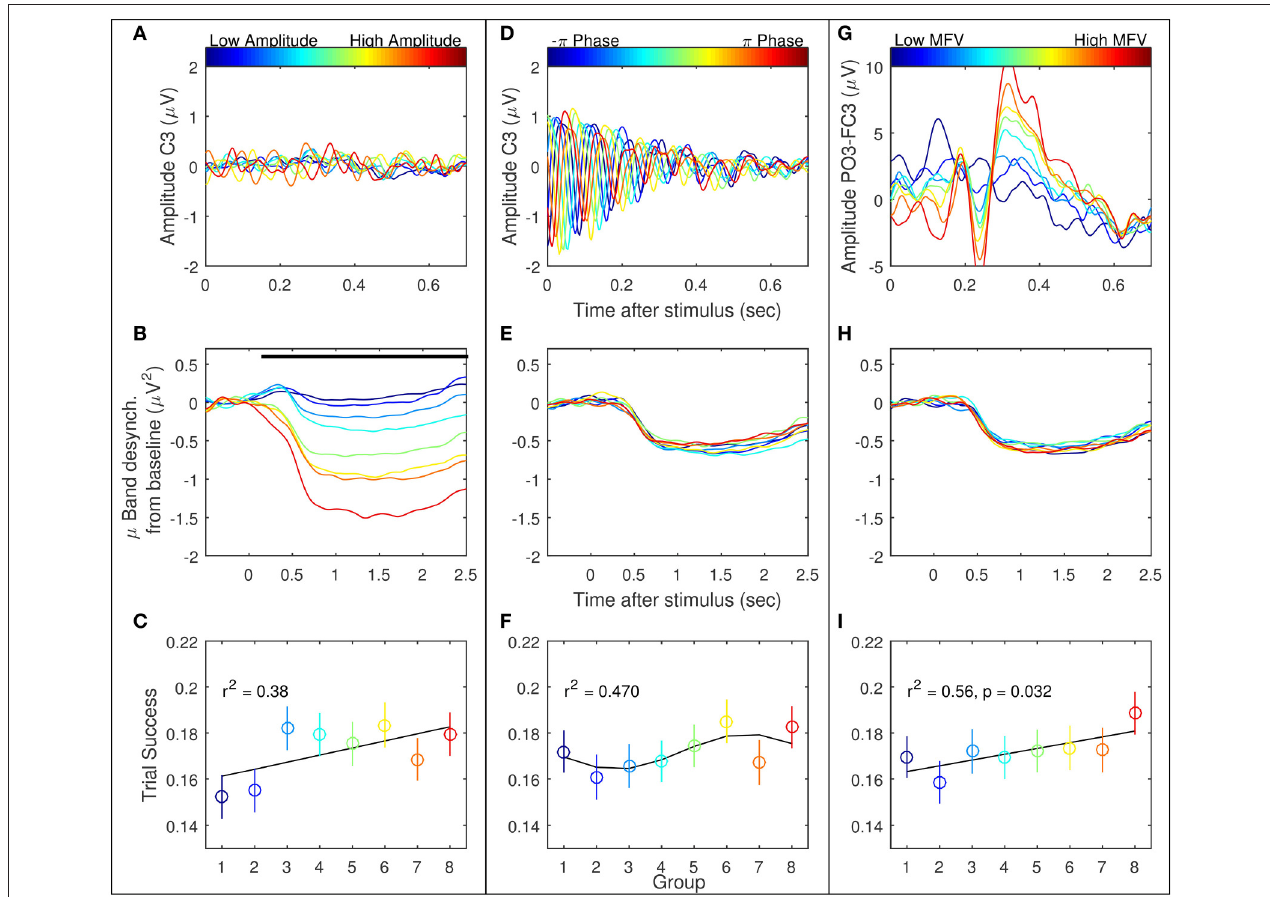
FIGURE 6 | Three EEG features were considered as potential gating variables (shown here are the left hemisphere features): mu amplitude in C3 at stimulus presentation (left column, A–C), mu phase in C3 at stimulus presentation (middle column, D–F), and match to PO3-FC3 VEP template (right column, G–I). Refer to Figure 5 for further